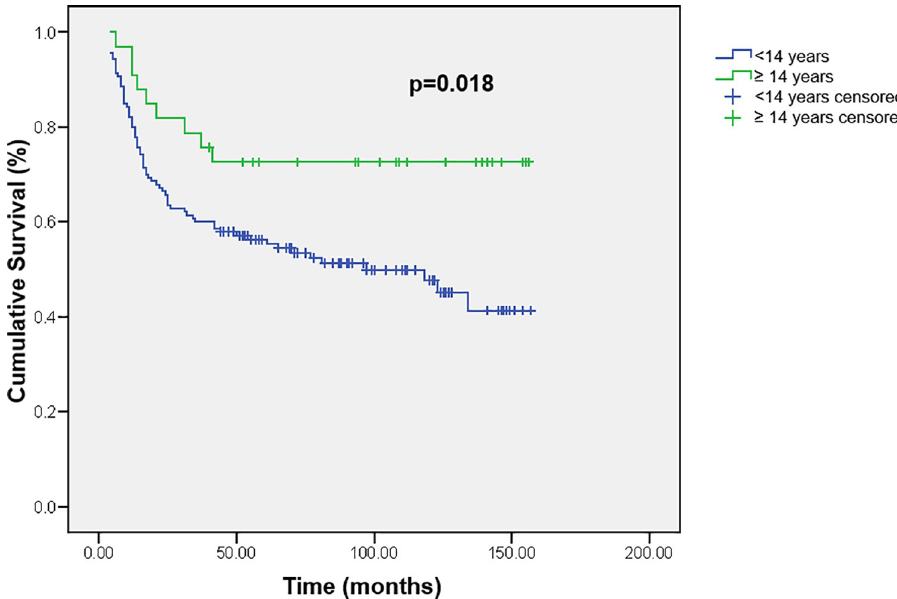
Fig 2. Cumulative survival of children with brain tumors according to